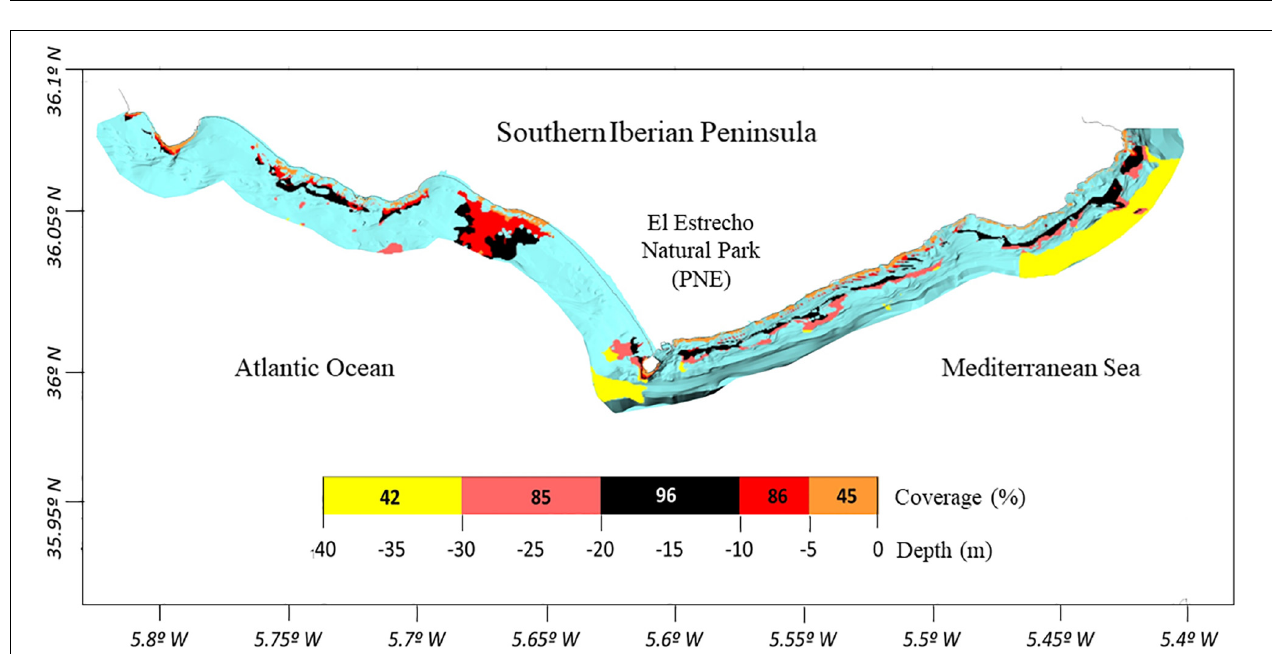
FIGURE 4 | Mean percentage coverage of R. okamurae in the (A) bathymetric range obtained from the southern coasts of the Strait of Gibraltar (Ceuta) in summer 2018 (García-Gómez et al., 2020b) and (B) average mean percent coverage estimated for the bathymetric intervals of the sublittoral PNE rocky areas. Standard deviation error bars are included in both cases.